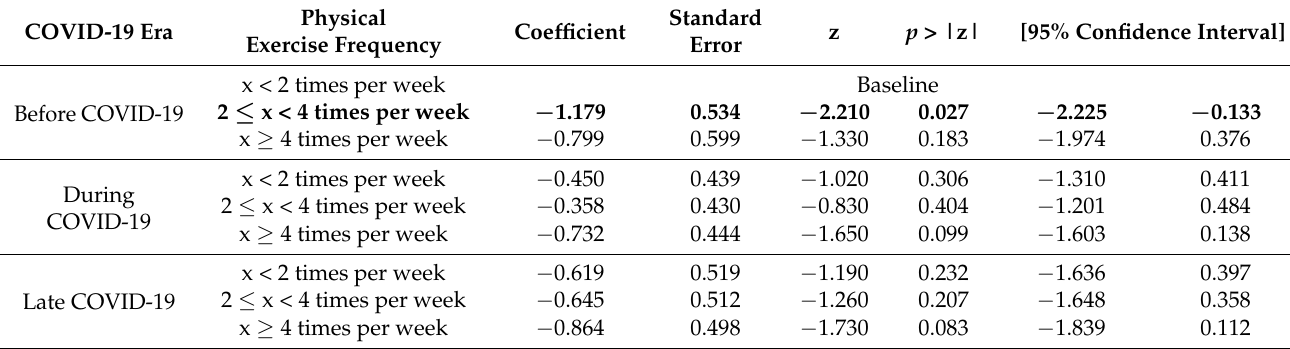
Table 10. The effect of COVID-19 era and physical exercise frequency on mental distress in men during weekdays.